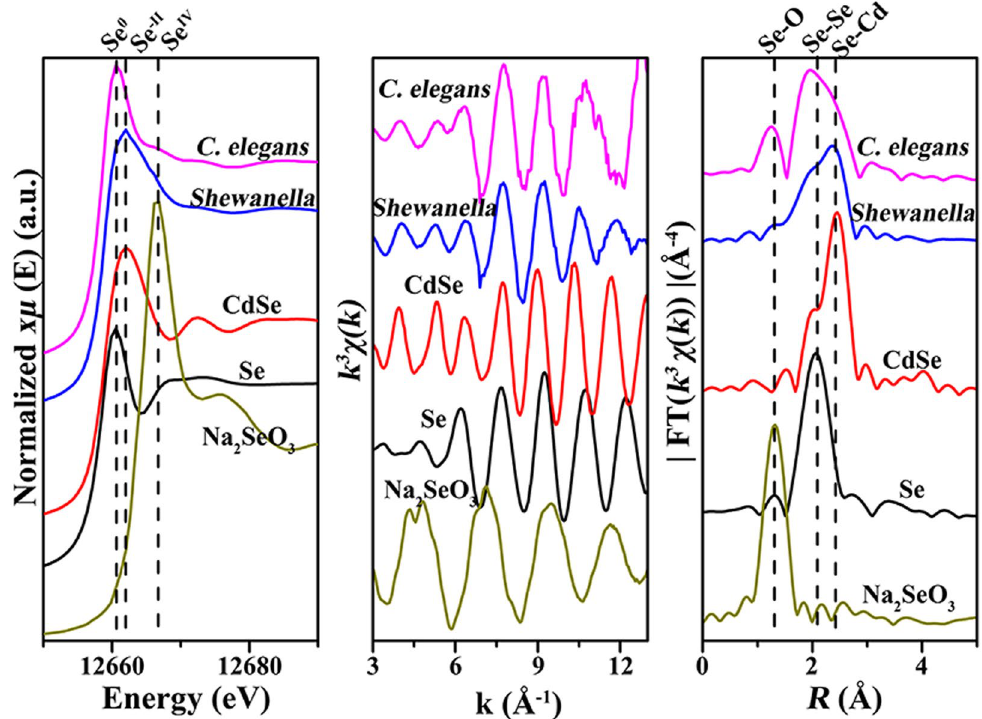
Figure 5. Changes of Se chemical species during food-chain transfer. ( a ) Se K -edge normalized XANES spectra of references Se (Se: elemental selenium, Na 2 SeO 3 : sodium selenite and CdSe: cadmium selenide) and biological samples. ( b ) Se K -edge EXAFS k 3 χ ( k ) functions and ( c ) Fourier transformed of Se K -edge EXAFS k 3 χ ( k ) functions of biological samples and